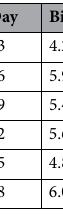
Table 2. Putative C. jejuni counts (log 10 CFU/g) in excreta samples of C. jejuni -positive moved